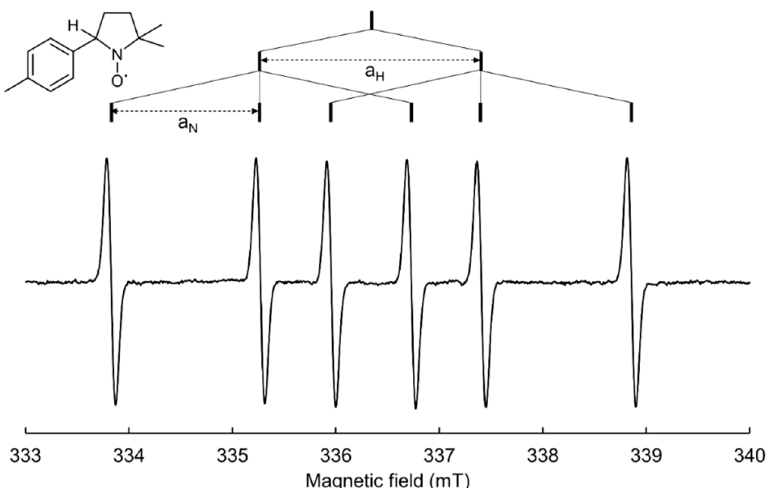
Figure 2. Representative X-band EPR spectrum of the 4-methylphenyl radical spin adduct of DMPO, the structure of which appears in the upper left corner. The stick diagram shown above the spectrum facilitates the interpretation of the hyperfine splitting pattern.